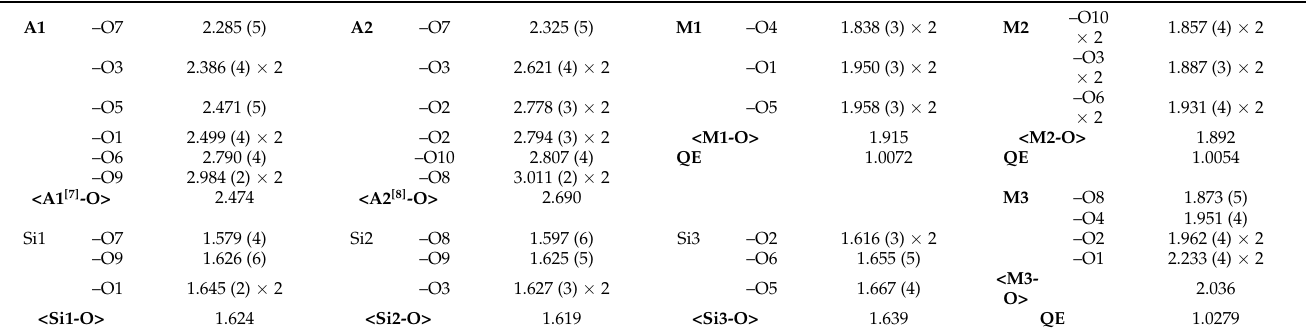
Table 9. Selected bond distances (Å) and QE distortion parameter [42] for coordination polyhedra in hancockite.